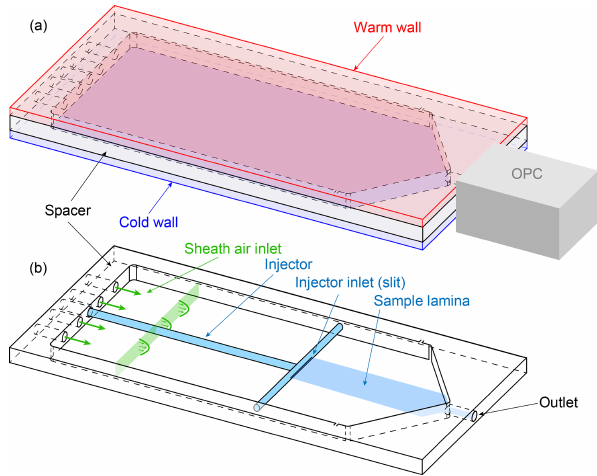
Figure 1. A schematic of HINC, the building platform of HINC- Auto: (a) the entire chamber and (b) the internal